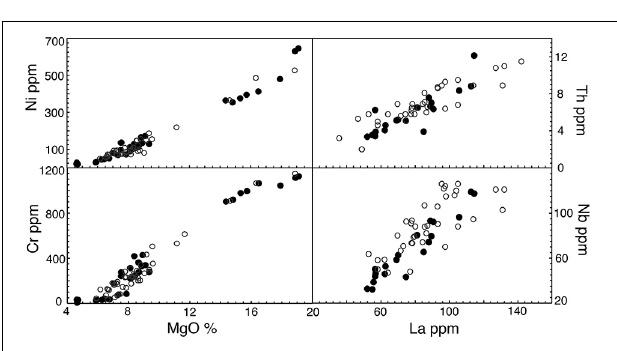
FIGURE 4 | Variations in trace elements among RVP lavas. Filled circles are new analyses whereas open circles are from Furman (1995). Compatible elements Ni and Cr consistently trend positively with MgO; some incompatible trace elements like Th and Nb broadly trend positively with